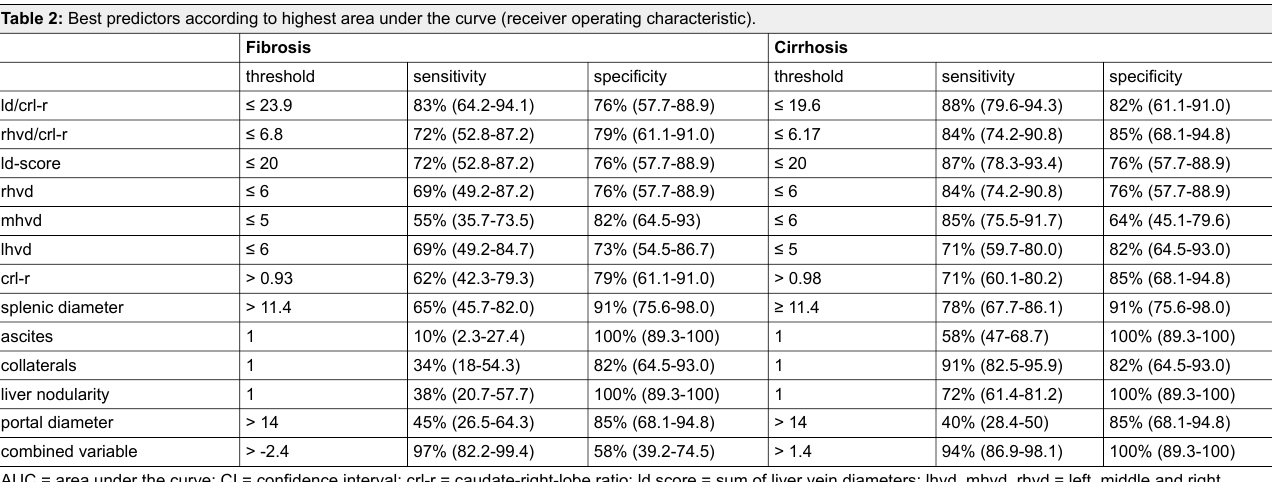
AUC = area under the curve; CI = confidence interval; crl-r = caudate-right-lobe ratio; ld score = sum of liver vein diameters; lhvd, mhvd, rhvd = left, middle and right hepatic vein diameter; ld/crl-r = ld score divided by crl-r; rhvd/crl-r = rhvd divided by crl-r p-values are for comparisons with the variable with the highest AUC entry (highest AUC entry and significant difference